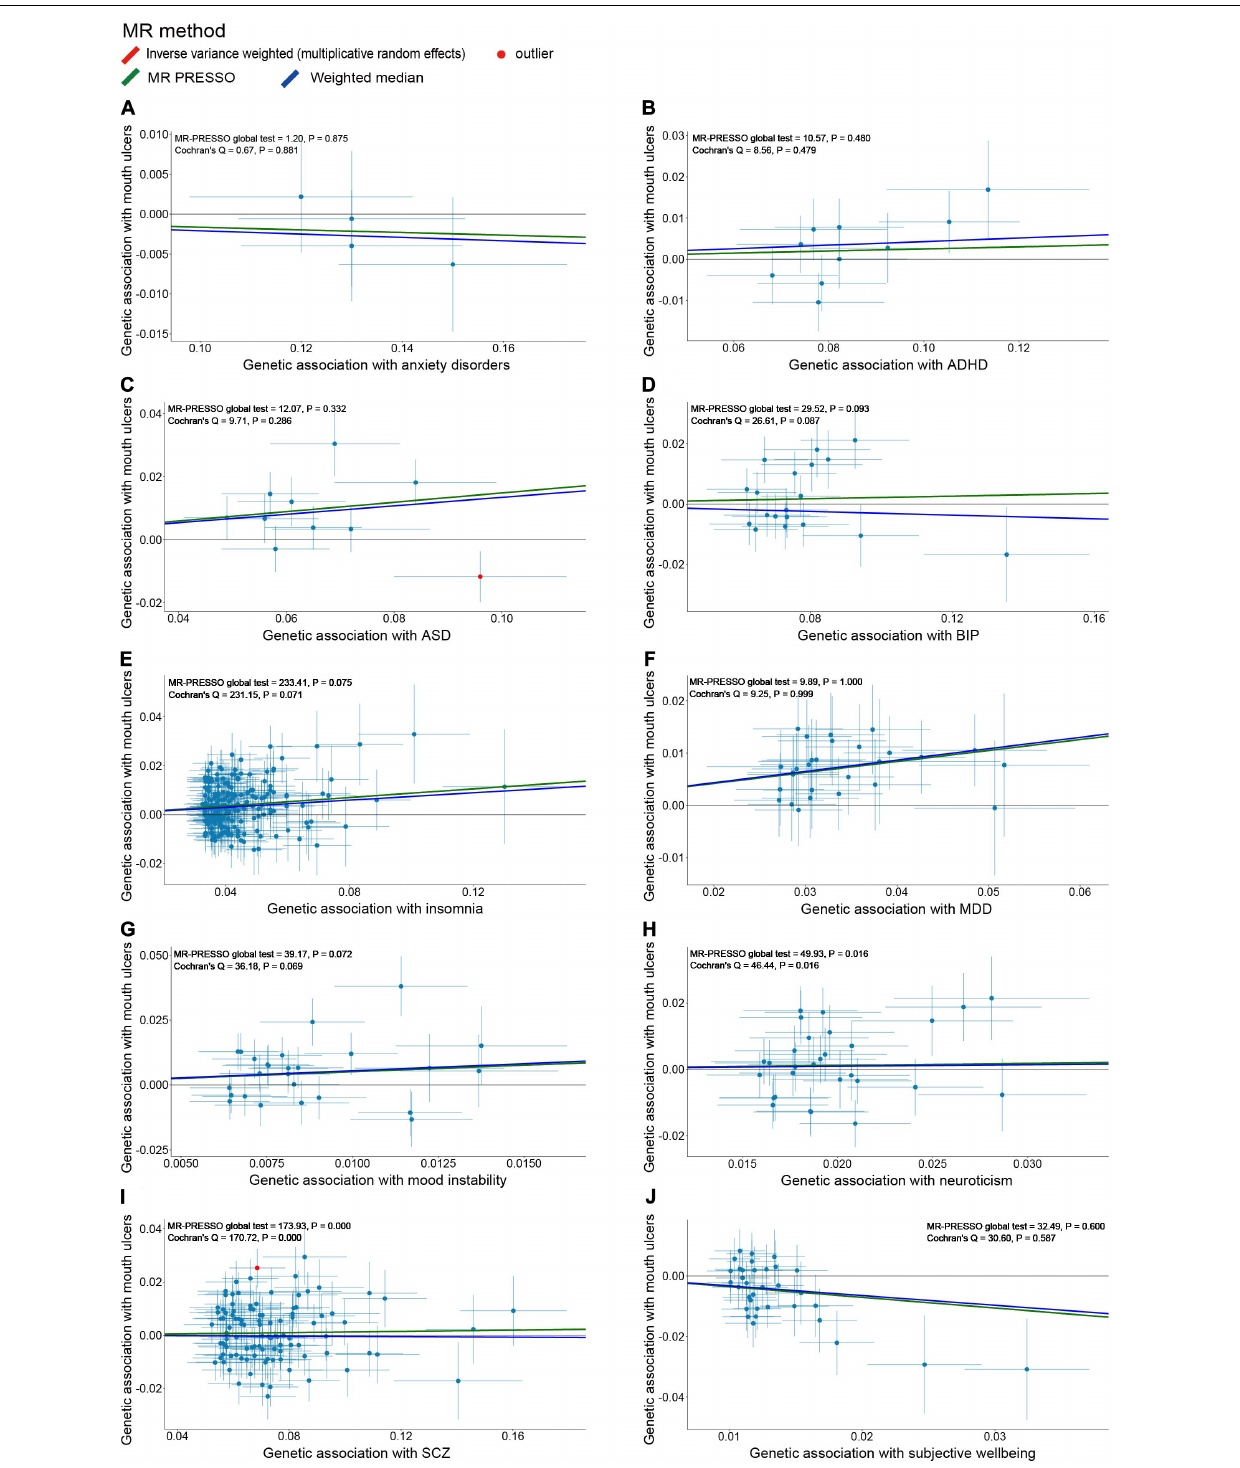
FIGURE 2 | Scatter plots of genetic associations with mouth ulcers (outcome) vs. genetic associations with 10 psychiatric traits (exposure) for all the valid IVs. (A) anxiety disorders; (B) ADHD; (C) ASD; (D) BIP; (E) insomnia; (F) MDD; (G) mood instability; (H) neuroticism; (I) SCZ; (J) subjective wellbeing. Each dot corresponds to one genetic variant, with corresponding standard error bars of its association with psychiatric trait (horizontal) and mouth ulcers (vertical); solid red dot represents the pleiotropic SNP (outlier) identified by MR-PRESSO global test; the solid lines illustrate estimations of the causal effect after excluding outlier SNP, colored by different colors with different MR methods. The horizontal gray solid line indicates no effect. In this study, the causal effect estimations from the IVW_mre and MR-PRESSO are consistent, such that the red line (IVW_mre) is covered by the green line (MR-PRESSO), and no red line could be observed.